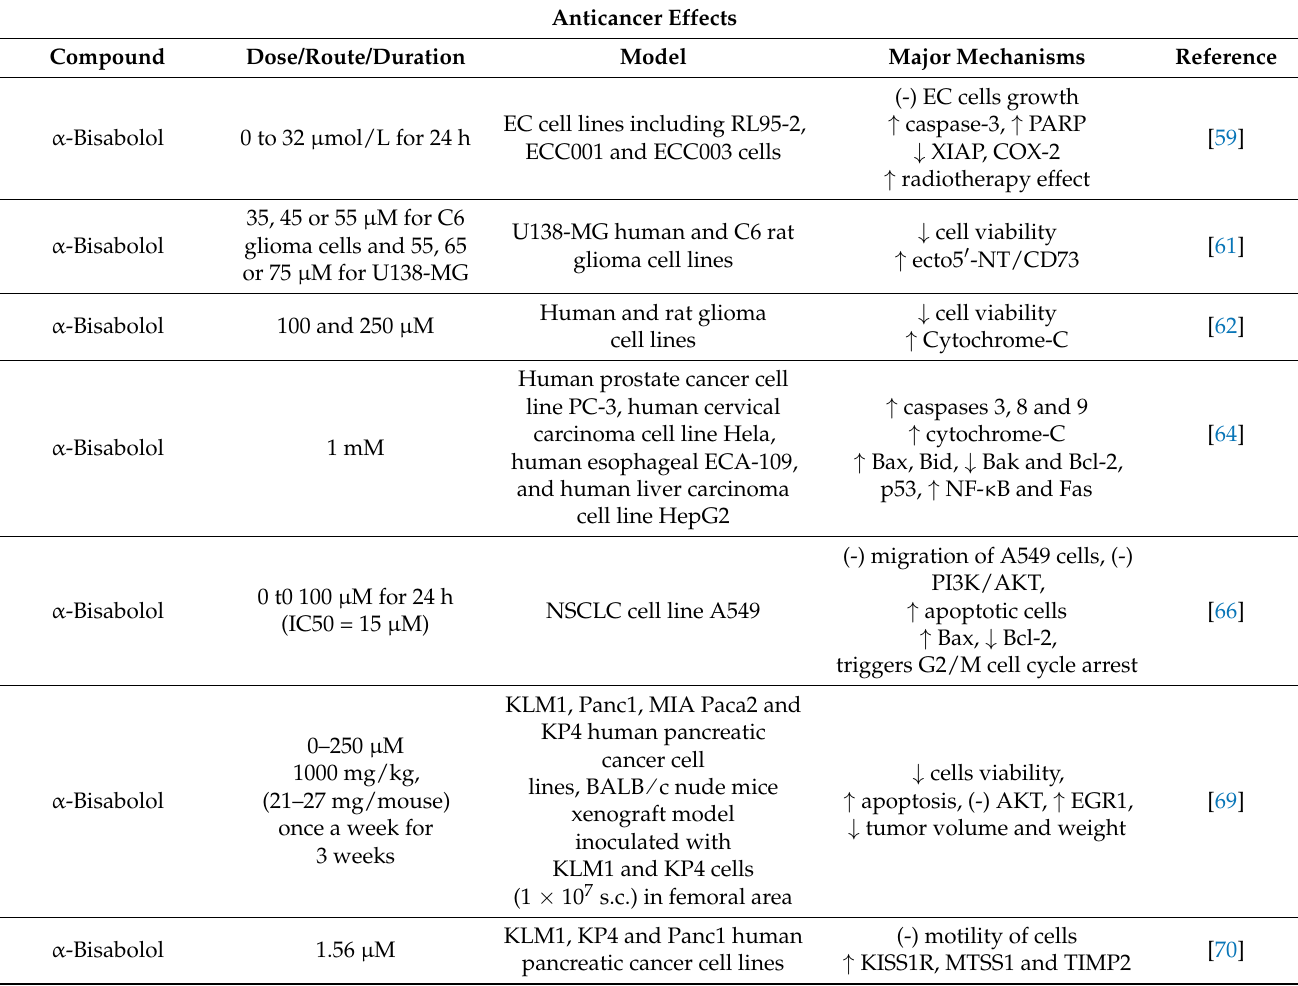
Table 5. Anticancer effects and demonstrated mechanisms of α -Bisabolol in the experimental models. Anticancer